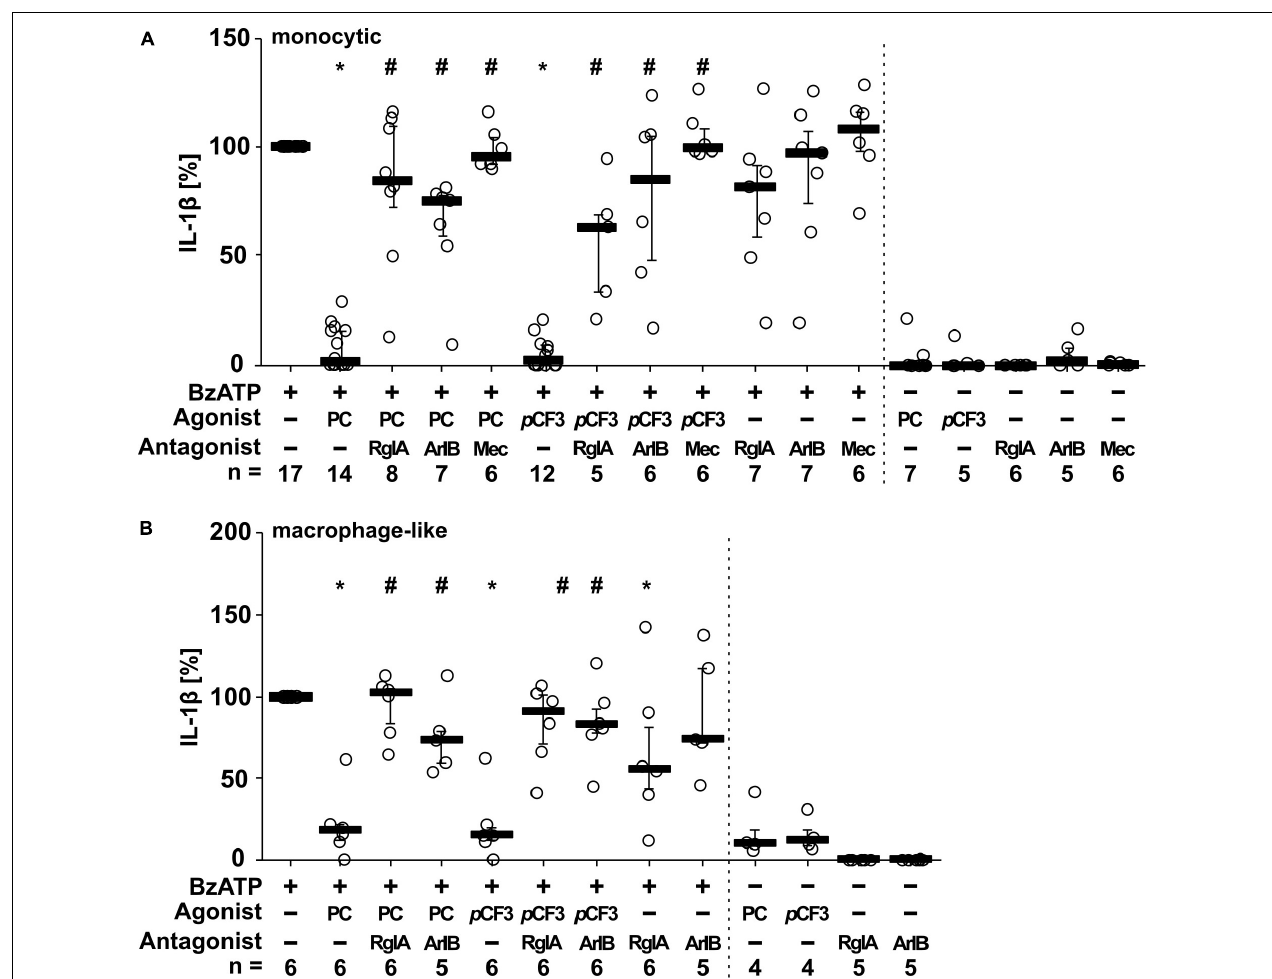
FIGURE 3 | Phosphocholine (PC) and the silent agonist p CF3-diEPP ( p CF3) inhibit the BzATP-mediated release of interleukin-1 β (IL-1 β ) by monocytic and macrophage-like THP-1 cells via nAChR subunits α 7, α 9 and/or α 10. Monocytic (A) and differentiated macrophage-like (B) THP-1 cells were used. Cells were primed with lipopolysaccharide (LPS; 1 µ g/ml, 5 h). Thereafter, the P2X7 receptor agonist BzATP [2 (cid:48) /3 (cid:48) -O-(4-benzoylbenzoyl)adenosine-5 (cid:48) -triphosphate, tri(triethylammonium) salt] was added for another 40 min to trigger IL-1 β release, which was measured by ELISA. The BzATP (100 µ M)-induced release of IL-1 β was investigated in the presence and absence of PC (200 µ M), the synthetic silent agonists p CF3 (100 µ M), antagonistic conopeptides RgIA4 (RgIA; 200 nM; specific for nAChRs composed of subunits α 9 and α 10) or [V11L, V16D]ArIB (500 nM; specific for α 7 nAChR subunit) and the non-competitive, non-specific nAChR antagonist mecamylamine (Mec; 100 µ M). The concentration of IL-1 β released in response to BzATP was calculated by subtracting the IL-1 β concentrations measured in supernatants of cells treated with LPS alone. In each experiment, the IL-1 β concentration obtained after stimulation with BzATP was set to 100% and all other values were calculated accordingly. Data are presented as individual data points, bars represent median, whiskers encompass the 25 th to 75 th percentile. * p ≤ 0.05, different from LPS-primed cells stimulated with BzATP alone; # p ≤ 0.05 significantly different from samples, where BzATP plus agonist was given. Friedman-test followed by the Wilcoxon signed-rank